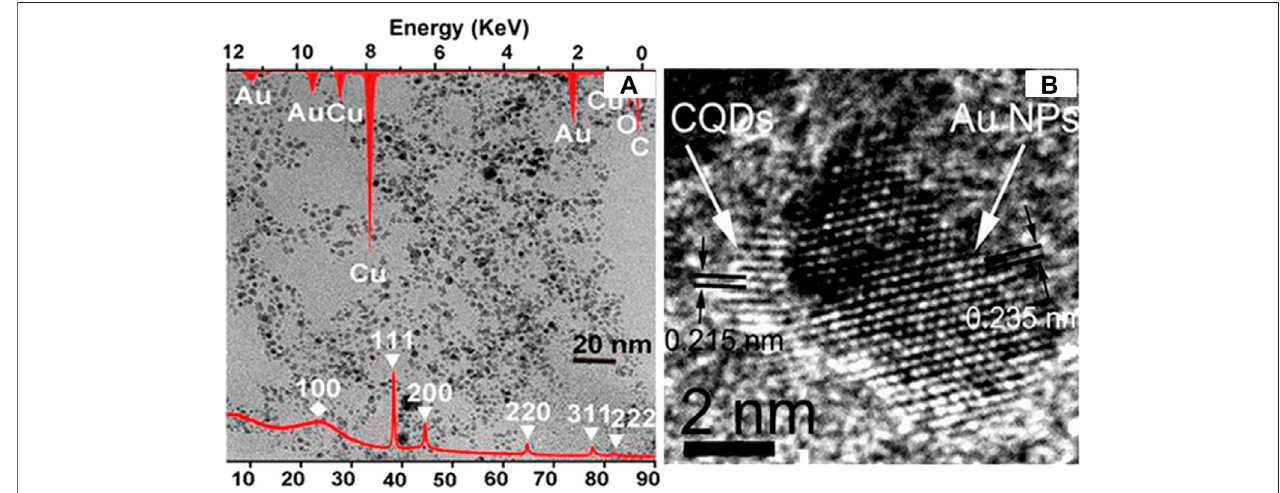
FIGURE9|(A) Transmissionelectronmicroscopy(TEM)image,X-raydiffraction(XRD)pattern(shownastheredoverlayatthetopportionofthepanel)andenergy- dispersive X-ray (EDX) spectrum (shown as the red overlay at the bottom portion of the panel) of Au/CQDs composites; (B) high-resolution transmission electron microscopy (HTEM) image of Au/CQDs composites. (Reproduced with permission from Liu et al., 2014, Copyright © 2014 American Chemical